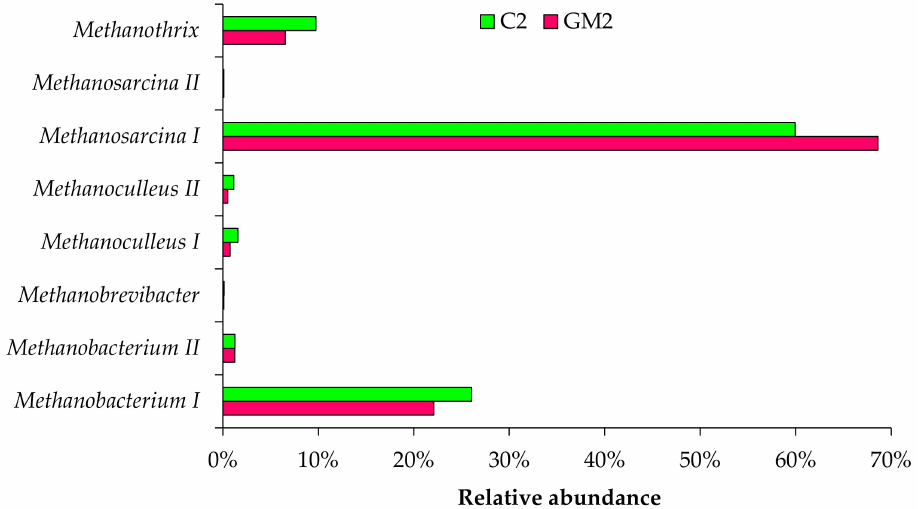
Figure 8. Taxonomic composition of methanogenic communities in the anaerobic reactors according to amplicon sequencing of mcrA gene (sampled on day